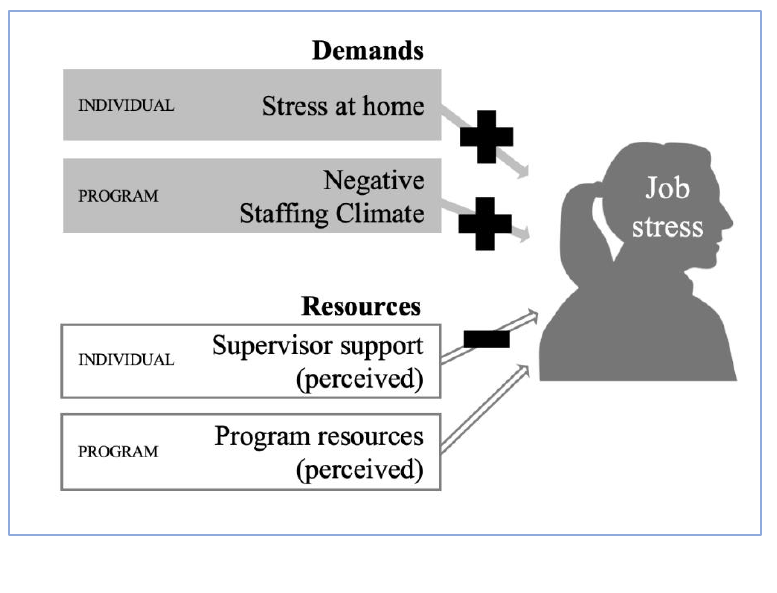
Figure 2. Relationships Between Program and Individual Demands and Resources and